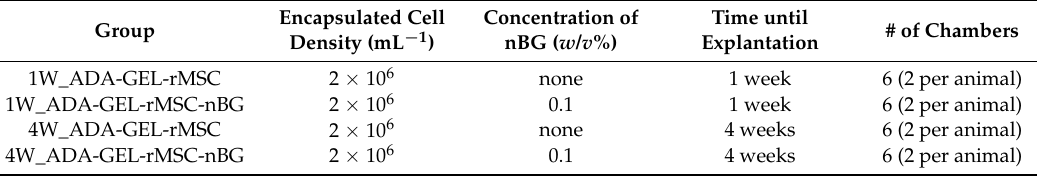
Table 1. In vivo study design. nBG: gelatin and nano-scaled bioactive